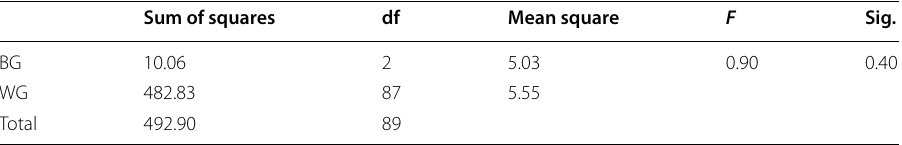
BG between groups, WG within groups